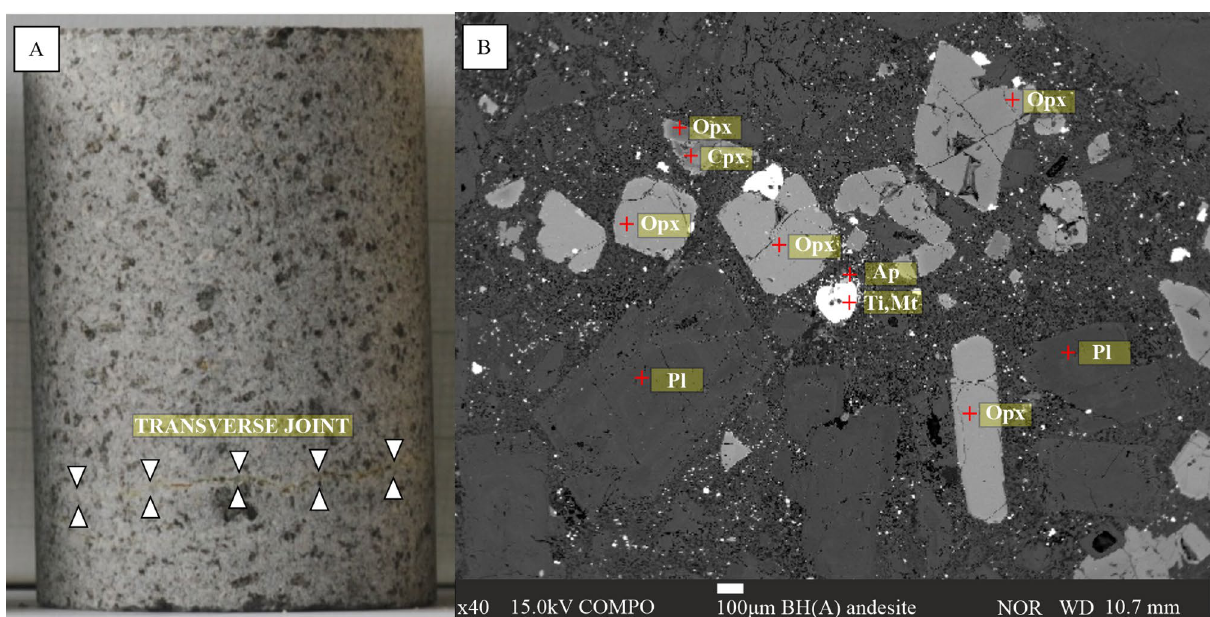
Figure 1. ( A ) Macro photo of BH(A) specimen with transverse joint; ( B ) Mineralogical composition on standard thin section by